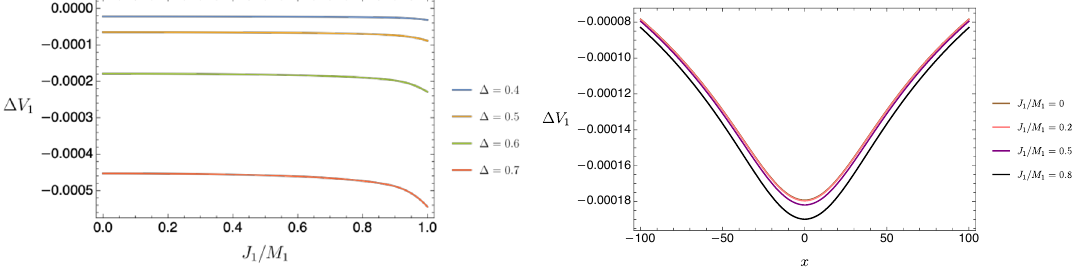
(right). In both panels, we choose h = 1 , λ = 1 , G 1